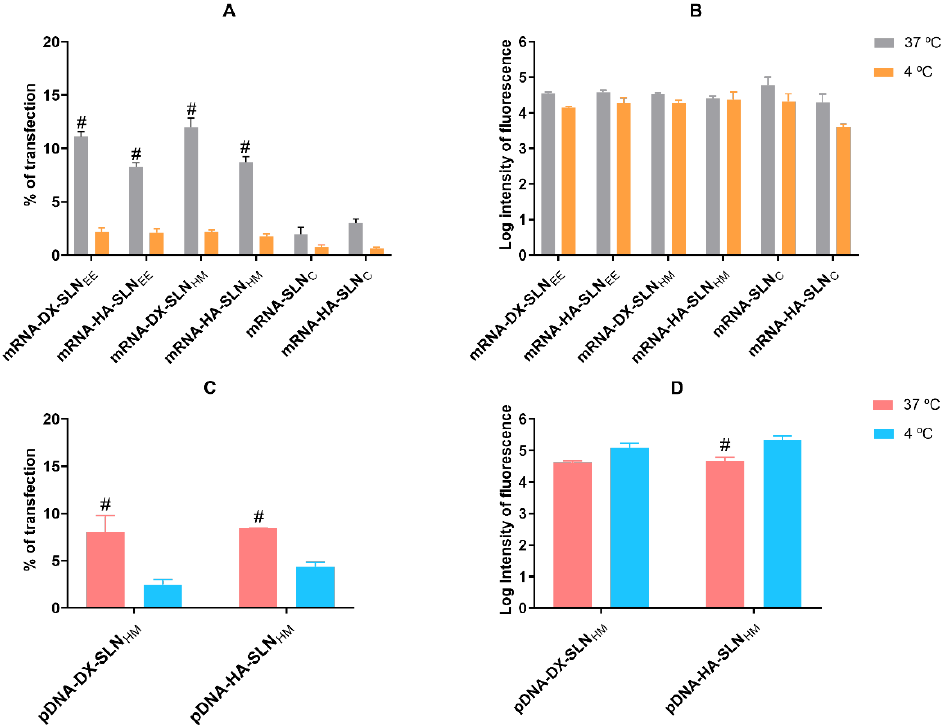
Figure 2. Flow cytometry analysis of transfection efficacy and intensity of fluorescence of HCE-2 cells after the addition of SLN EE , SLN HM and SLN C vectors at 37 °C and 4 °C. Percentage of trans- fection values correspond to the positive fluorescent GFP cells over the total cells. Log of intensity of fluorescence indicates the average intensity of fluorescence per labeled cell. Data are expressed as mean ± standard deviation; n = 3. ( A ) Percentage of transfected HCE-2 cells at 37 °C and 4 °C 48 h after administration of mRNA-based vectors. ( B ) Log of intensity of fluorescence of transfected HCE-2 cells 48 h after administration of mRNA-based vectors. ( C ) Percentage of transfected HCE-2 cells at 37 °C and 4 °C 72 h after administration of pDNA-based vectors. ( D ) Log of intensity of fluorescence of transfected HCE-2 cells 72 h after administration of pDNA-based vectors. # p < 0.05 with respect to the same vector at 4 °C. DX: dextran; HA: hyaluronic acid; SLN EE : solid lipid na- noparticle prepared by emulsification-evaporation method. SLN HM : solid lipid nanoparticle pre- pared by hot-melt emulsification method. SLN C : solid lipid nanoparticle prepared by coacervation